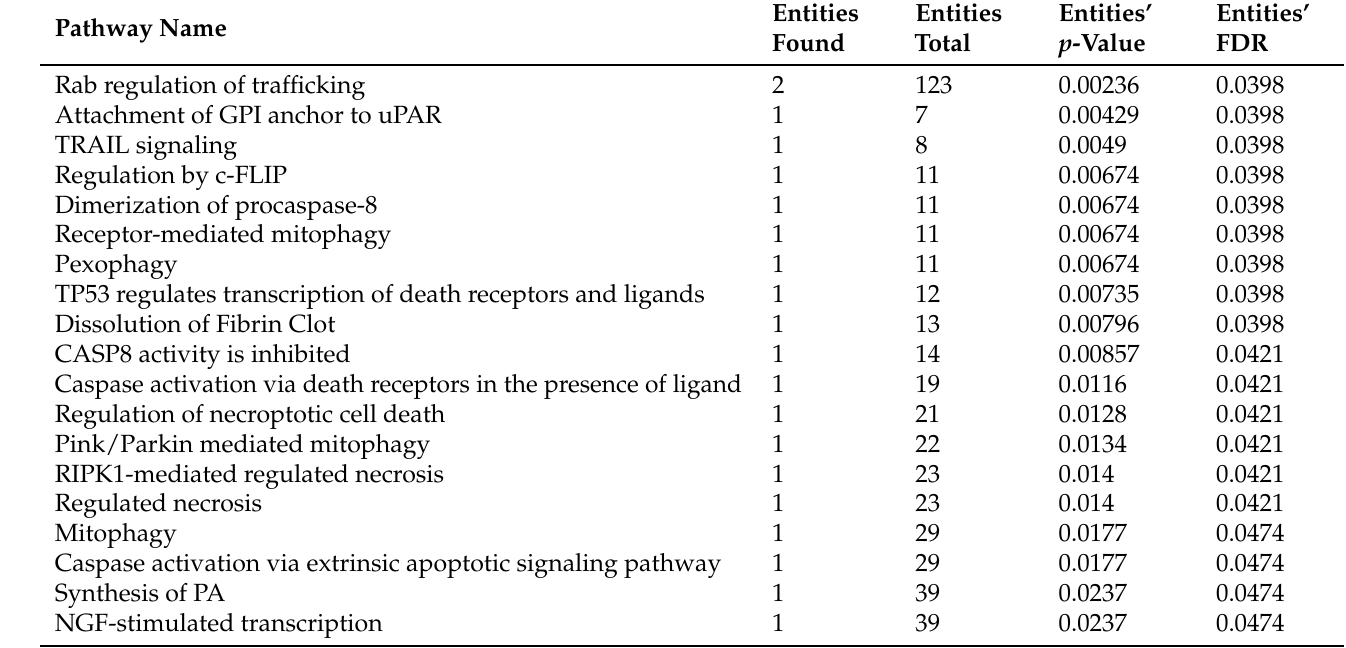
Table 3. List of pathways significantly connected to upregulated proteins. As the input for Reactome analysis, we used a list of all protein groups that were significantly changed (adj. p value < 0.05) between control and sample in both conditions and upregulated (Log2FC > 1). Listed are 20 pathways with a higher p -value; each entity’s p -value and FDR was calculated by the Reactome